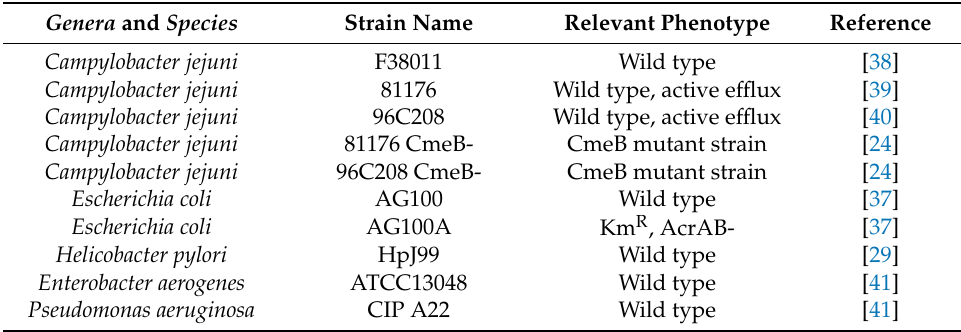
Table 4. Strains used in this